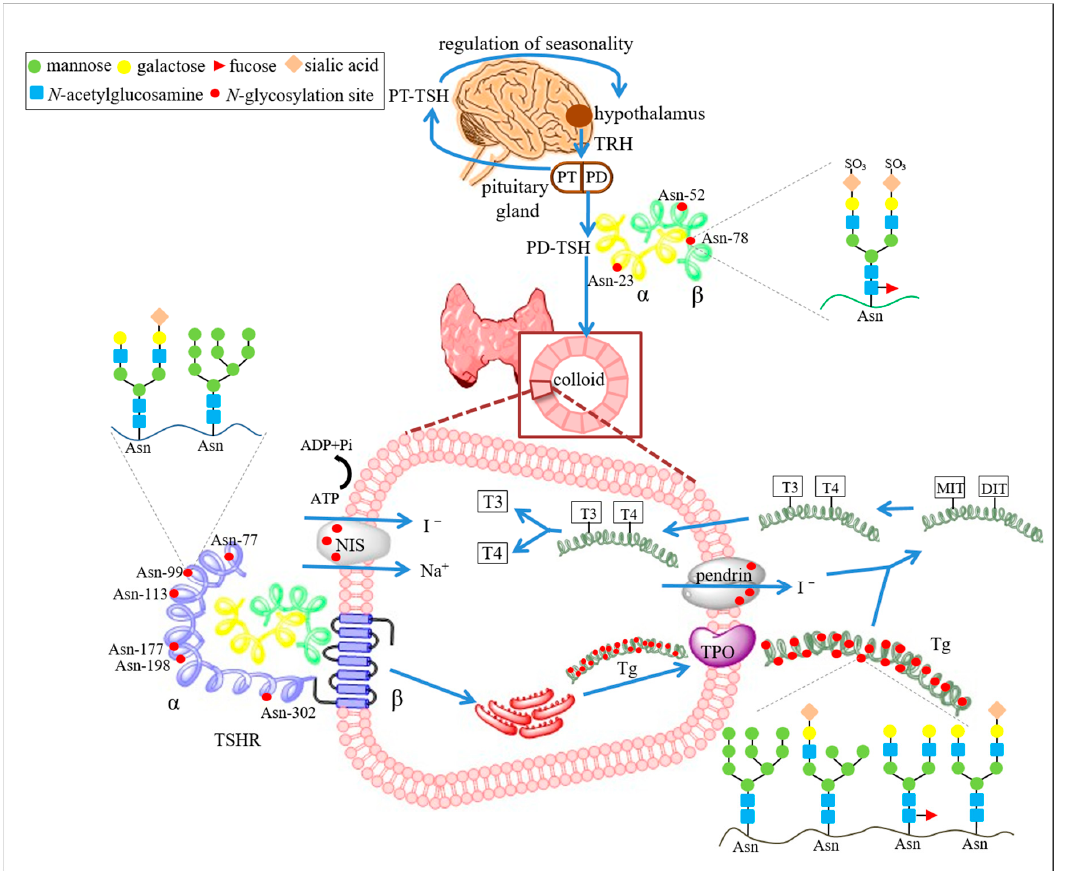
Figure 2. Glycosylation of the key thyroid proteins. Synthesis of thyroid hormones is regulated by the hypothalamus-pituitary-thyroid axis. Thyrotropin-releasing hormone (TRH), produced by the hypothalamus, stimulates the pituitary gland to release thyroid-stimulating hormone (TSH). PD-TSH is secreted by the pars distalis (PD) and PT-TSH by the pars tuberalis of the pituitary gland. PT-TSH binds to the TSH receptor (TSHR) in the hypothalamus and regulates seasonality. PD-TSH binds to TSHR in the cell membrane of thyrocytes and induces signal transduction, resulting in thyroglobulin (Tg) synthesis [31]. Thyroperoxidase (TPO) catalyzes iodine oxidation, iodination of Tg, and production of monoiodotyrosine (MIT) and diiodotyrosine (DIT). The combination of MIT and DIT gives triiodothyronine (T3), while tetraiodothyronine, also called thyroxine (T4), consists of two coupled DITs [3–5]. Sodium/iodide symporter (NIS) is responsible for active transport of iodide ions through the thyroid follicular cell membrane into thyrocytes. Pendrin, an anion transporter located in the apical membrane of thyrocytes, is involved in iodide transport from follicular cells into the lumen of follicles [32]. All the above-mentioned human thyroid proteins are N -glycosylated and contain different numbers of N -glycosylation sites (red dots): TSH–3 (Asn23, Asn52, Asn78) [6], TSHR–6 (Asn77, Asn99, Asn113, Asn177, Asn198, Asn302) [33], Tg–16 (Asn57, Asn179, Asn465, Asn510, Asn729, Asn797, Asn928, Asn1200, Asn1329, Asn1345, Asn1696, Asn1754, Asn1993, Asn2230, Asn2275, Asn2562) [34], NIS–3 (Asn485, Asn497, Asn225) [32,35], pendrin–3 [36]. TSH is abundant in sulfated biantennary N -glycans [6]. TSHR contains high-mannose and complex-type structures [33]. High-mannose structures as well as galactosylated, fucosylated, and sialylated hybrid-type and complex-type N -glycans have been identified on Tg